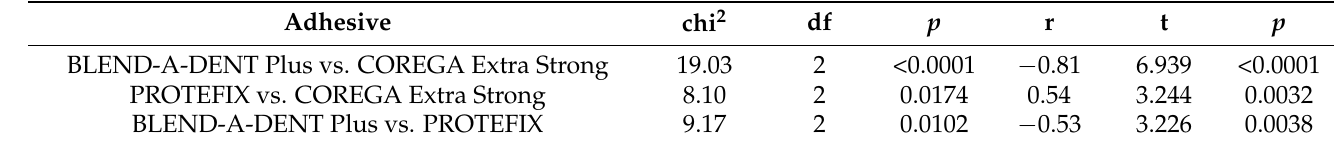
Table 7. Statistics for comparisons between